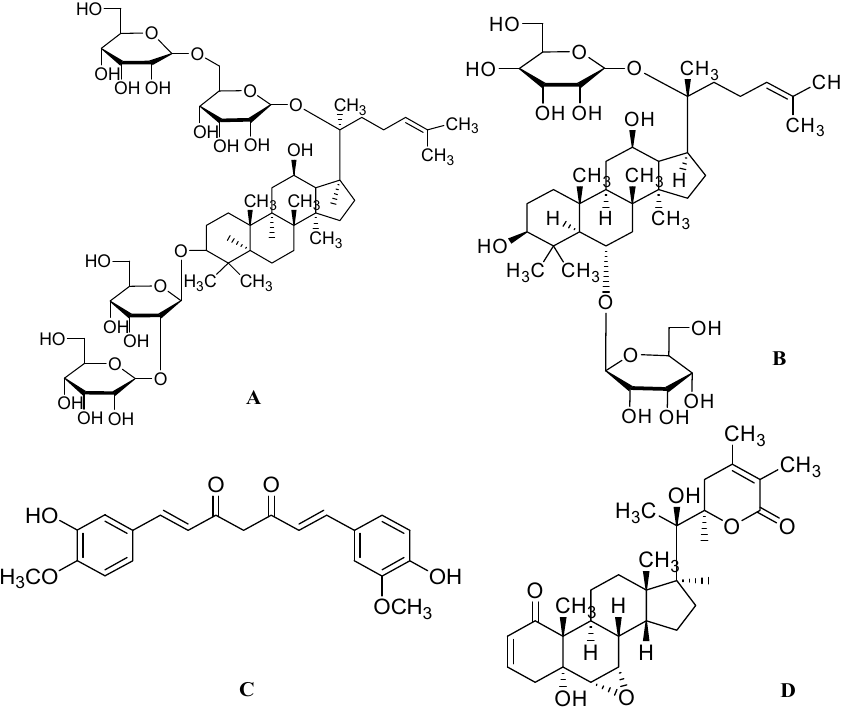
Figure 1. The molecular structures of ginsenoside Rb1 ( A ), ginsenoside Rg1 ( B ), curcumin ( C ) and withanolide A ( D